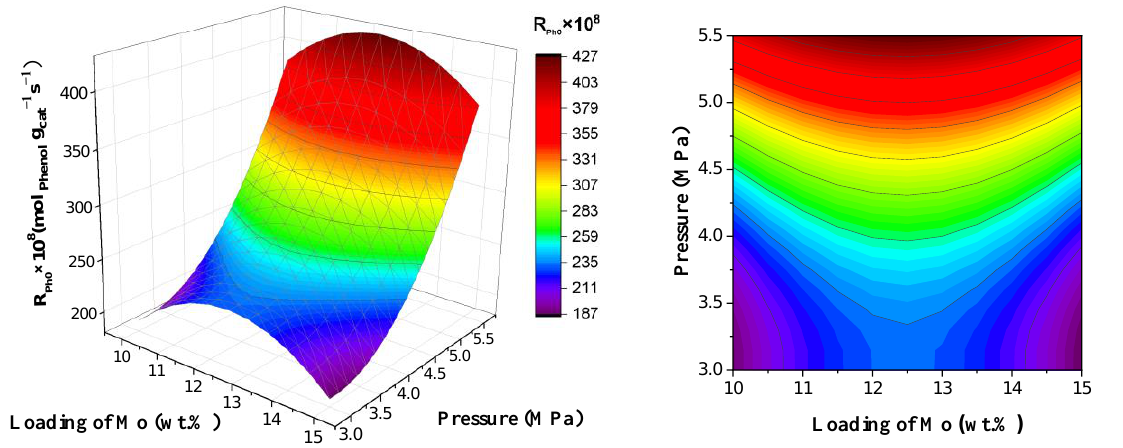
Figure 6. Response surface curve ( left ) and contour surface plot ( right ) corresponding to the initial reaction rate R PH0 of the HDO of phenol over CoMo/AT2 as a function of Mo loading (wt.%) and Pressure (MPa).